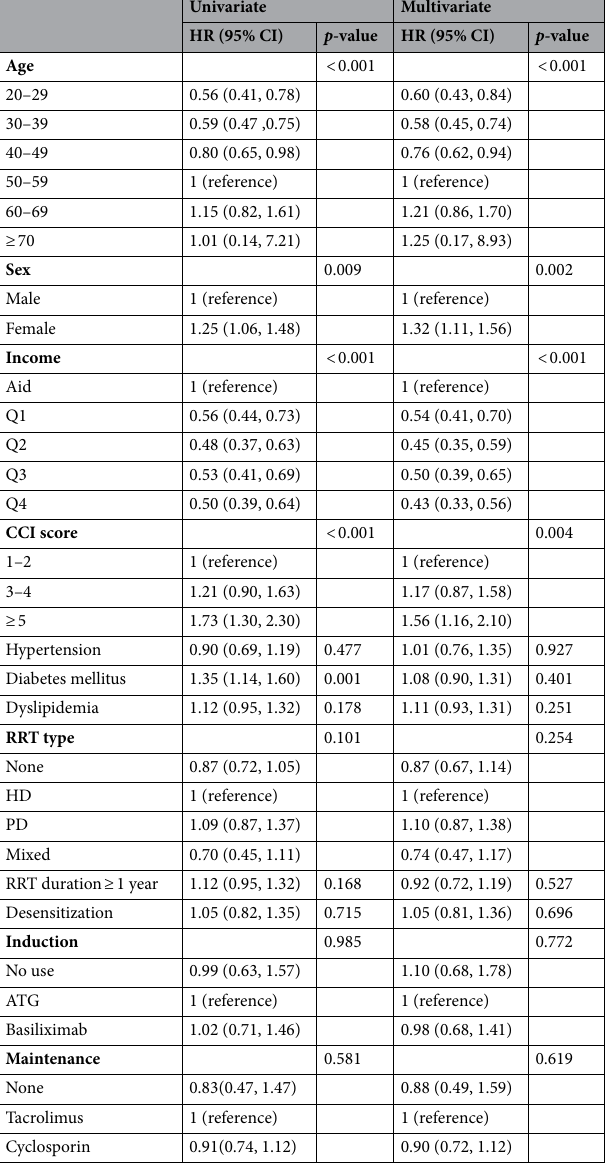
Table 5. Predictive risk factors for incident depression in KT group. KT kidney transplantation, CCI Charlson Comorbidity Index, RRT renal replacement therapy, HD hemodialysis, PD peritoneal dialysis, ATG antithymocyte globulin.